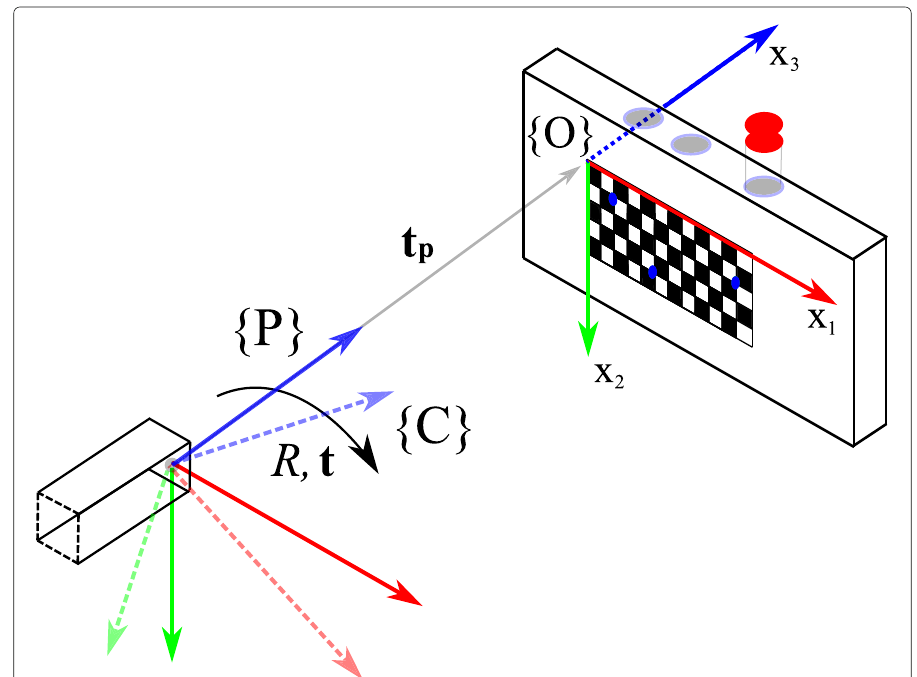
Fig. 3 The pose of the pinhole wrt the target (solid arrows) is known. The pose of the target wrt the camera (dashed arrows) is determined by a pose estimation algorithm. Using the origin { O } as a pivot, we can calculate the rotation R and translation t from { P } to { C } . The tracer is contained inside the vial with the red cap. Exit pupils (blue circles) of the target are used to direct gamma radiation from the tracer for the image augmentation to assess the